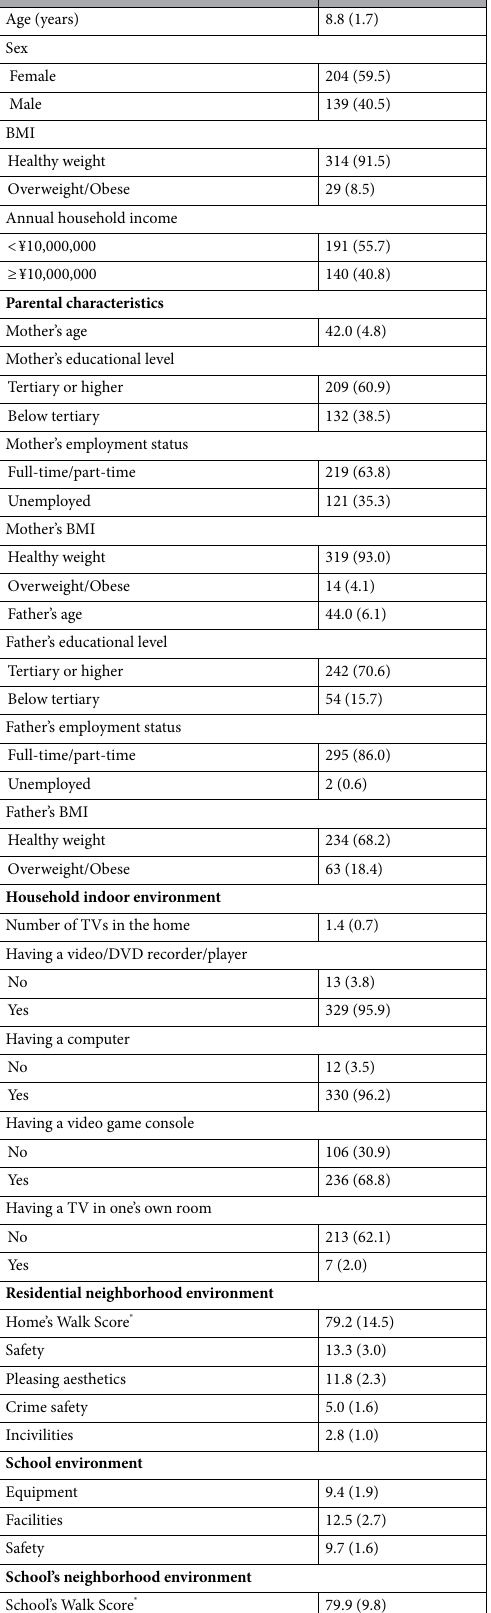
Table 1. Characteristics of study participants (N =